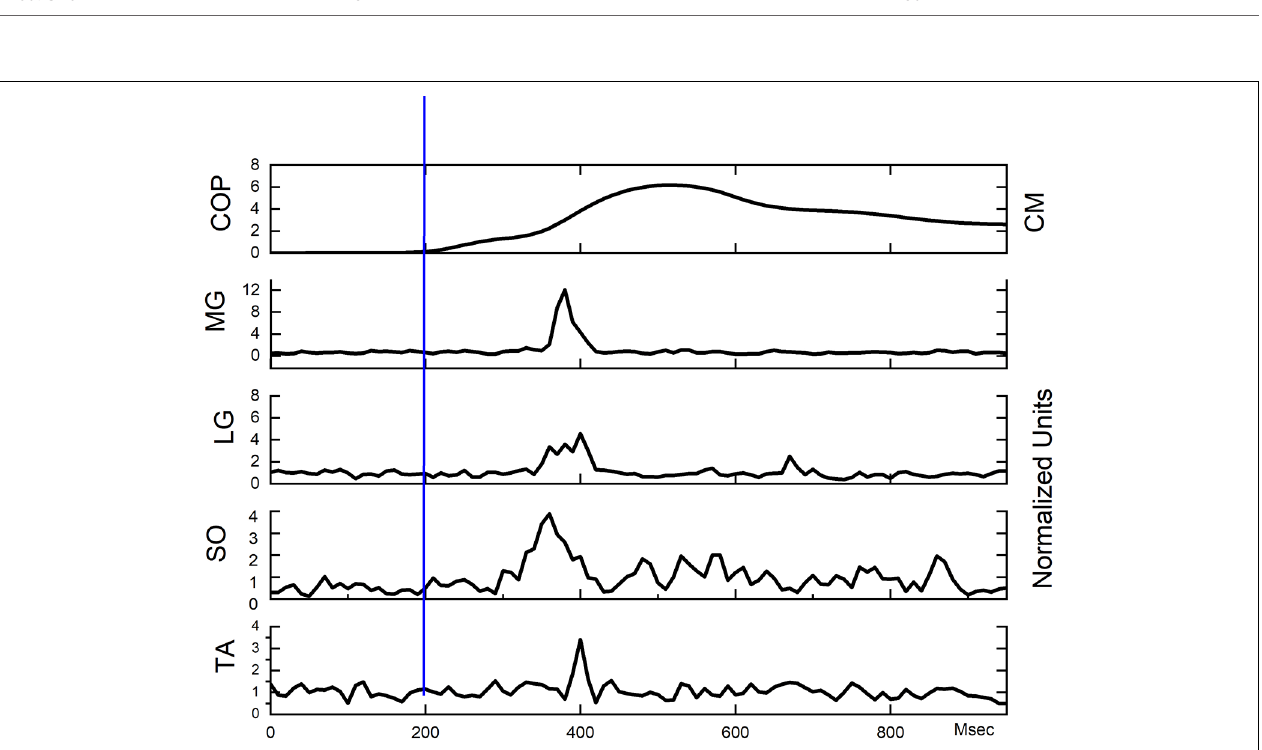
FIGURE 2 | Exemplar COP and EMG waveforms from a single participant. Perturbation onset occurred at 200 on the absciss (blue vertical line).